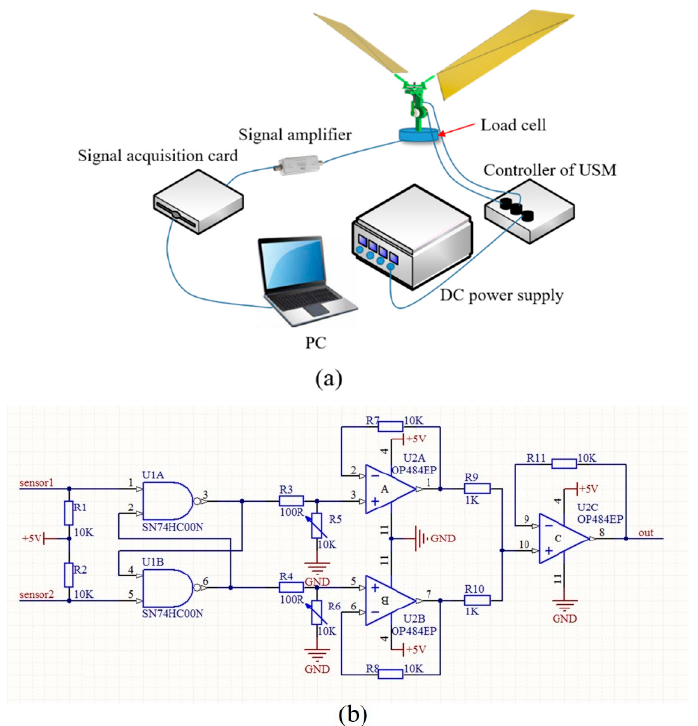
Figure 11. ( a ) Experimental components; ( b ) measurement circuits for the FWR